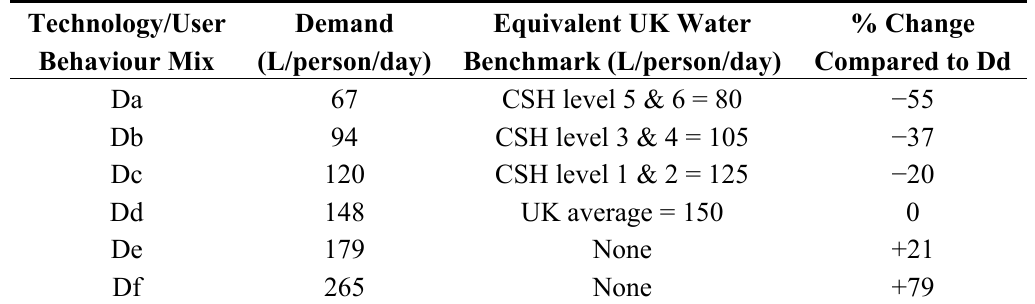
Table 8. Domestic demands achieved through changes in technology alone: “User behaviour” unchanged.